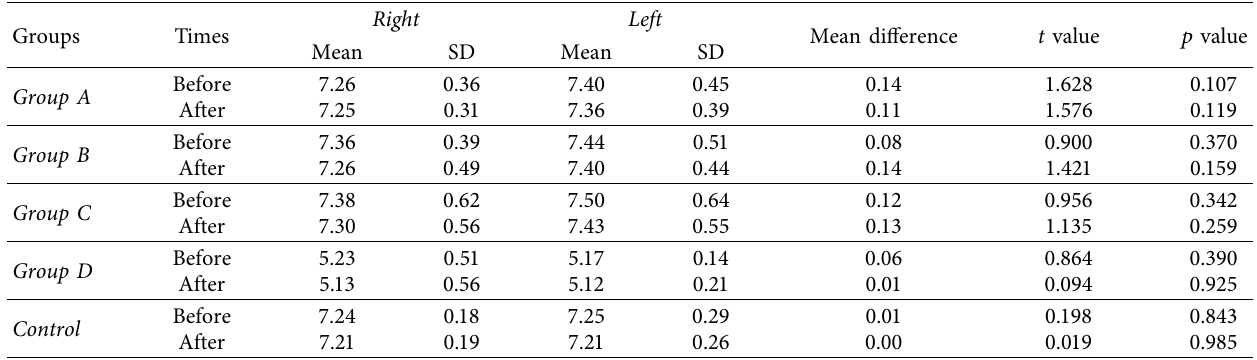
Table 9: Sidewise comparison of masseter muscle duration.